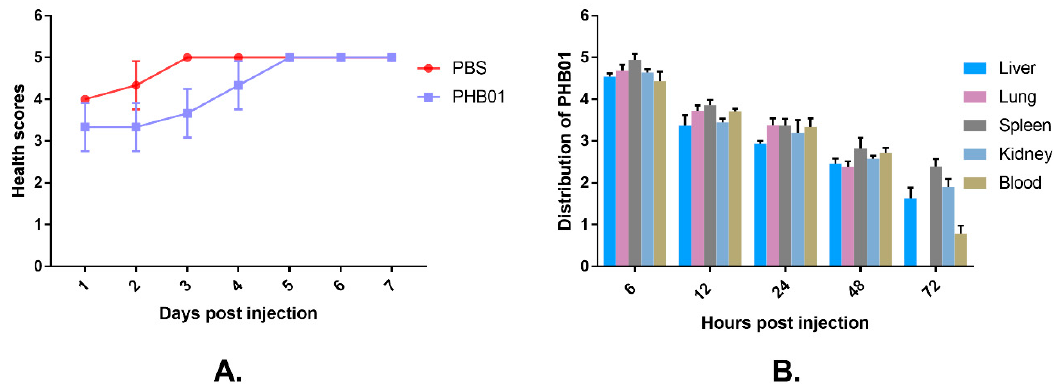
Figure 6. Safety test of PHB01 on mice. ( A ) Health scores given to the mice in different groups; ( B ) Distribution of phage PHB01 on the main organs of the mice. Data are presented as the mean ± SD.